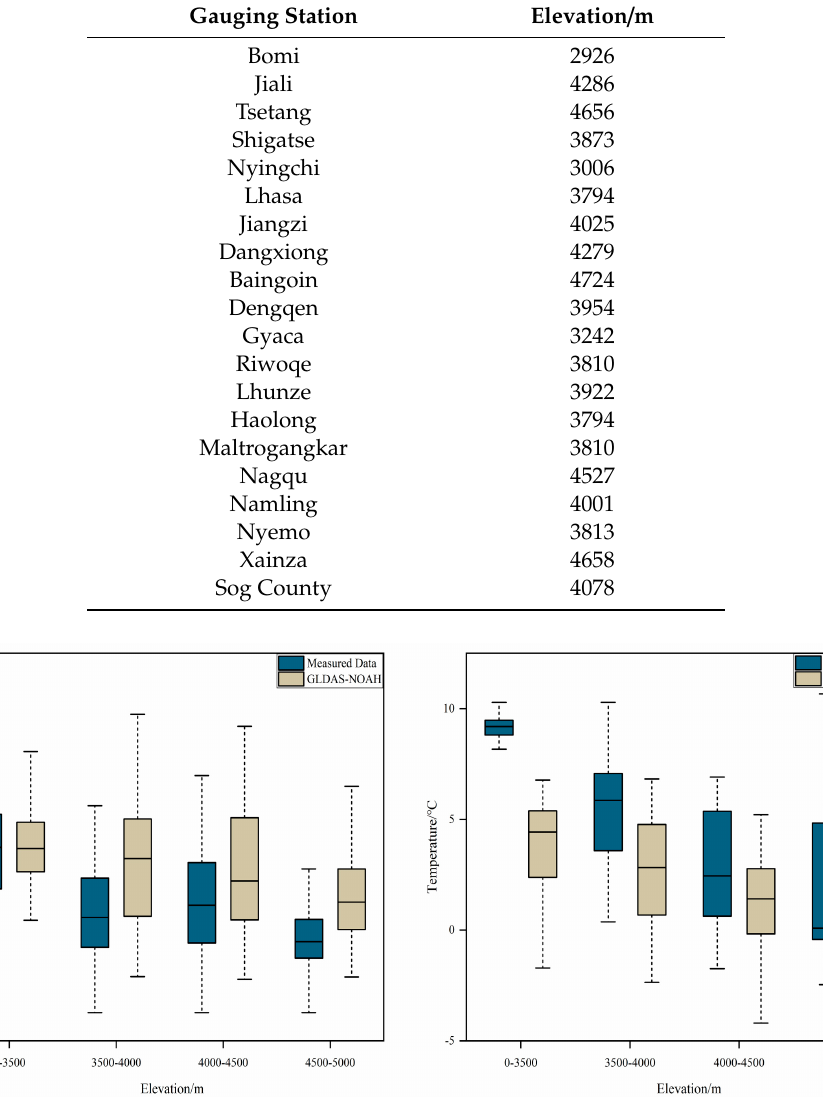
Figure 3 . Spatial performance of the measured and GLDAS-NOAH precipitation (left) and temperature